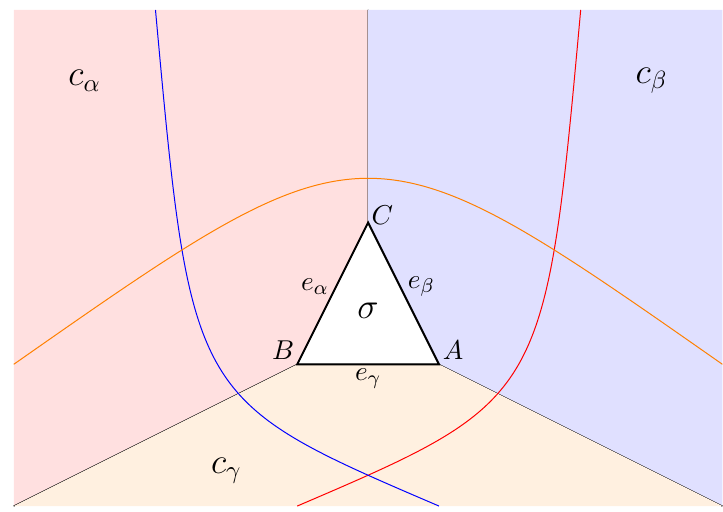
Figure 1 . In p = 2, there is a potential ambiguity in the action when a 2-simplex (cid:27) in our U -small chain complex lies in a triple intersection of open sets. In this diagram, U (cid:11) is the region to the left of the curved red line, such that Im c (cid:11) (cid:26) U (cid:11) , and U (cid:12) ( U (cid:13) ) are the regions to the right of (below) the curved blue (orange) lines respectively. The 0-, 1-, and 2-chains depicted are labelled as in the main